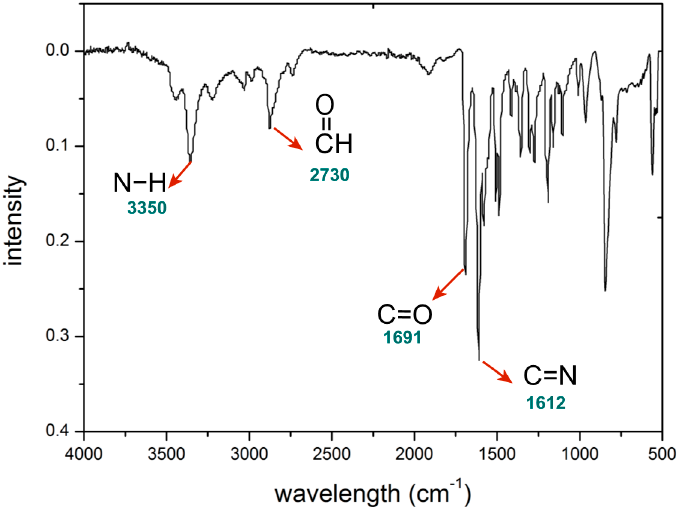
Figure 2. FT-IR spectrum of PAM.